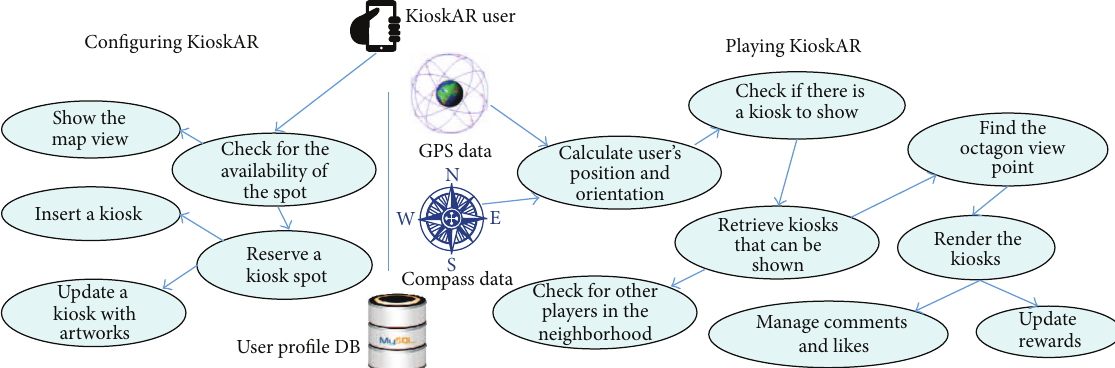
the virtual kiosks.